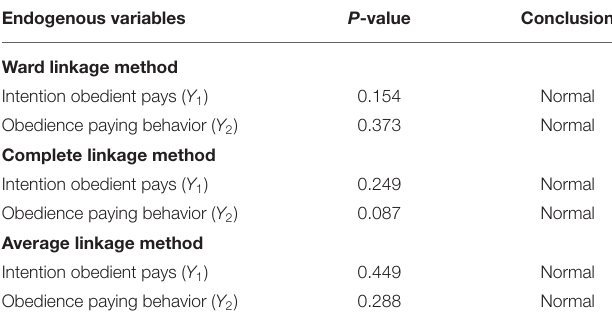
TABLE 1 | Number of members in each cluster of the ward linkage method.